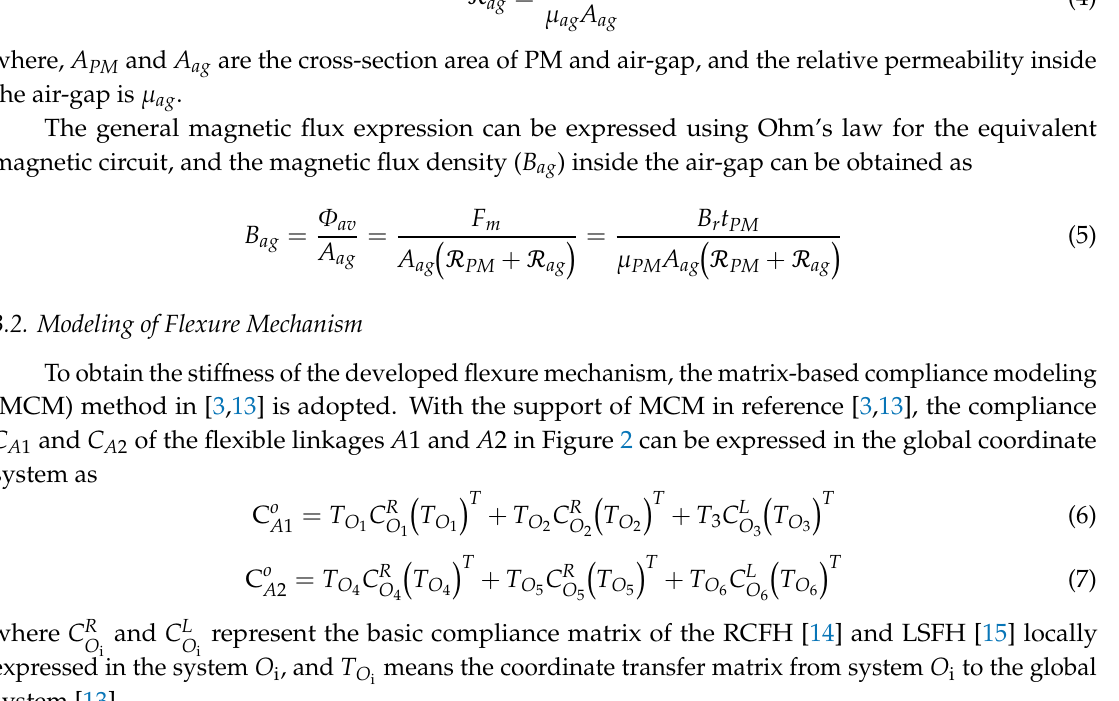
Figure 3. Lumped-circuit element based magnetic circuit model of the VCM, where 𝑡 𝑃𝑀 , 𝑡 𝑎𝑔 , 𝑡 𝑎 , and 𝑡 𝑦 are the thickness of the permanent magnet (PM), air-gap, armature, and yoke, respectively. 𝑙 𝑡 is the length from the outer face to the axis of the VCM. ℛ c1 , ℛ c2 , and ℛ c3 are the equivalent reluctance of the stator material.